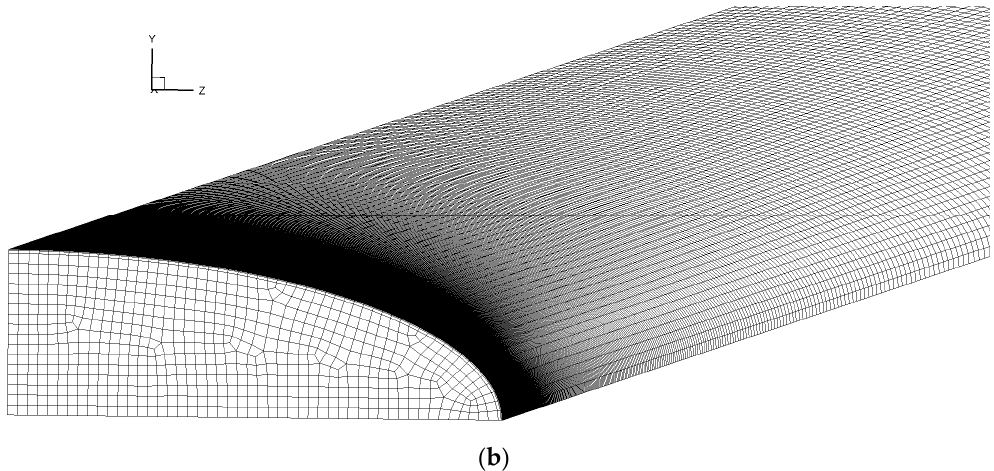
Figure 1. ( a ) Schematics of an elliptical minichannel; ( b ) numerical mesh of the quarter-channel computational domain.